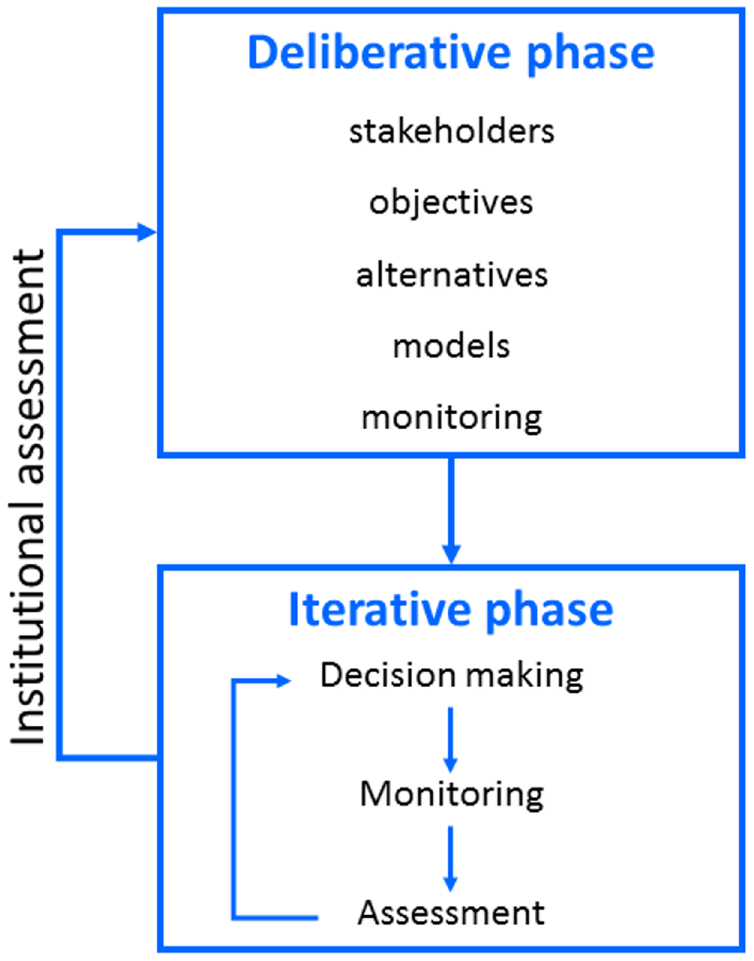
Fig 1. Learning in adaptive management. Technicallearninginvolvesan iterative sequenceof decision making, monitoring, assessment, and feedbackof what is learnedinto decisionmaking.Institutional learning involvesperiodicreconsideration of the componentsin decisionmaking (Williams and Brown [5]).